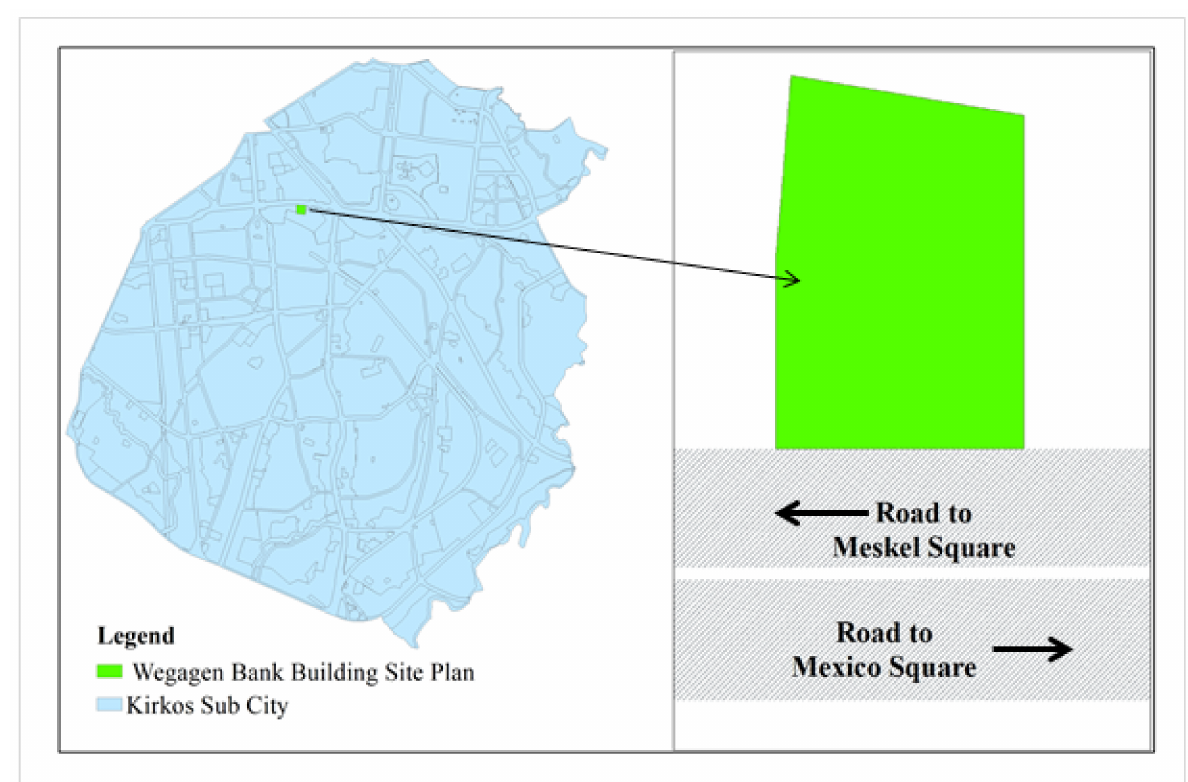
Figure 1. Map of the study